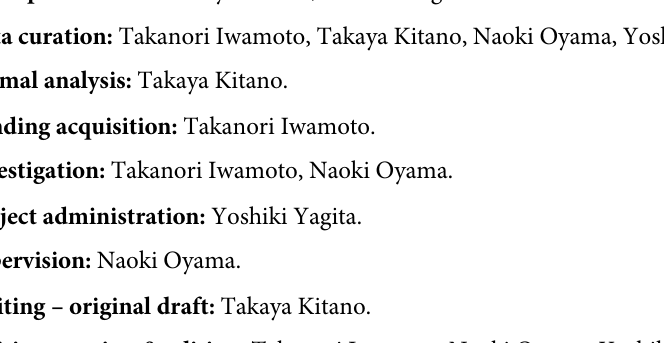
S1 Table. Association between favorable outcome and